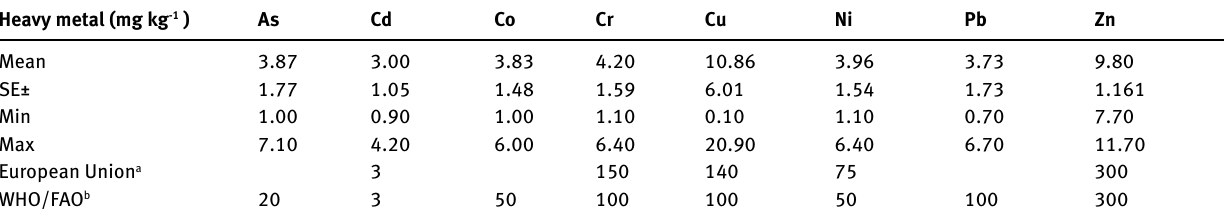
Table 1: Descriptive statistics of heavy metals in Epe, Igun and Ijana soil samples and the international maximum allowable standards Heavy metal (mg kg -1 )